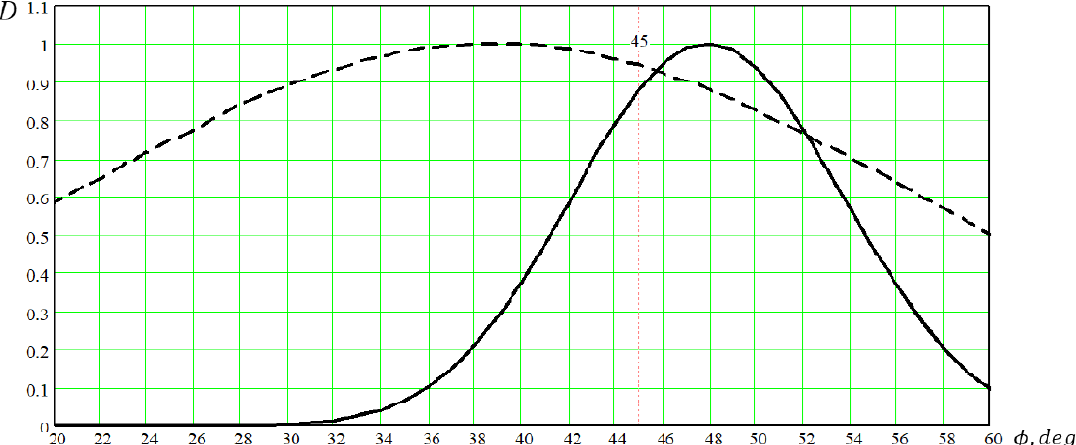
Figure 6. Correction of a Direction of Arrival (DOA) estimation by restoring the phase distribution of the field on a circle: 𝑓 (cid:3404) 90 MHz, 𝜙 (cid:3036)(cid:3041)(cid:3030)(cid:3036)(cid:3031)(cid:3032)(cid:3041)(cid:3030)(cid:3032) (cid:3404) 45° , 𝜙 (cid:3005)(cid:3016)(cid:3002).(cid:2928)(cid:2925)(cid:2931)(cid:2917)(cid:2918) (cid:3404) 61° , 𝜙 (cid:3005)(cid:2899)(cid:2885).(cid:2911)(cid:2913)(cid:2913)(cid:2931)(cid:2928)(cid:2911)(cid:2930)(cid:2915) (cid:3404) 43° D.